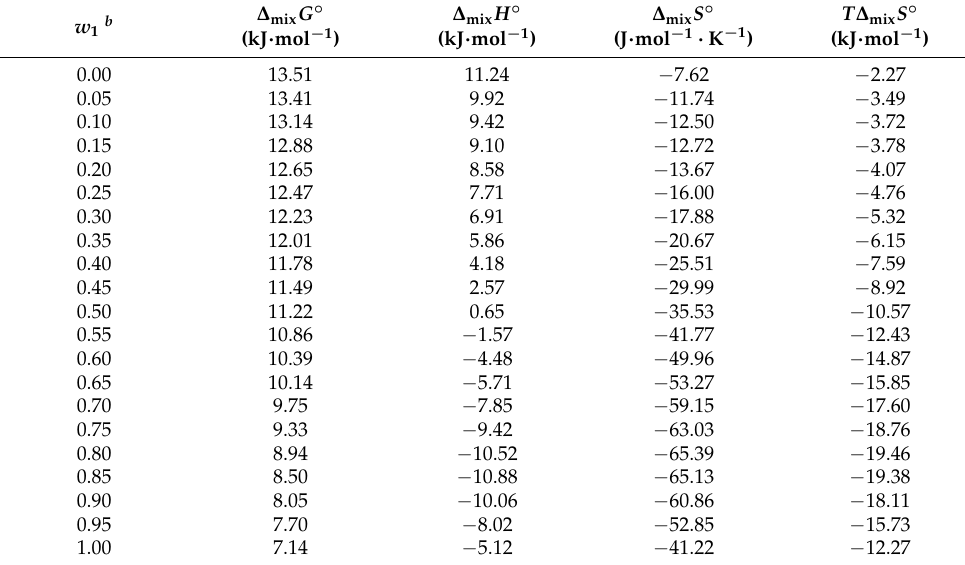
w 0.50 , the solution process is disfavored by the thermodynamic mixing functions, and from w 0.55 up to MeCN, the solution process is favored by the mixing enthalpy. According to Perlovich’s analysis (Figure 4) from 1-PrOH up to w 0.30 , the mixing process is driven by the enthalpy of mixing (Sector VIII: ∆ mix H ◦ > 0, T ∆ mix S ◦ < 0, ◦ | > | T ∆ ◦ | ); from w ◦ > 0, T ∆ ◦ < 0, | ∆ ◦ | ∆ | ∆ 0.30 to w 0.50 (Sector VII: mix H mix S mix H mix S mix H